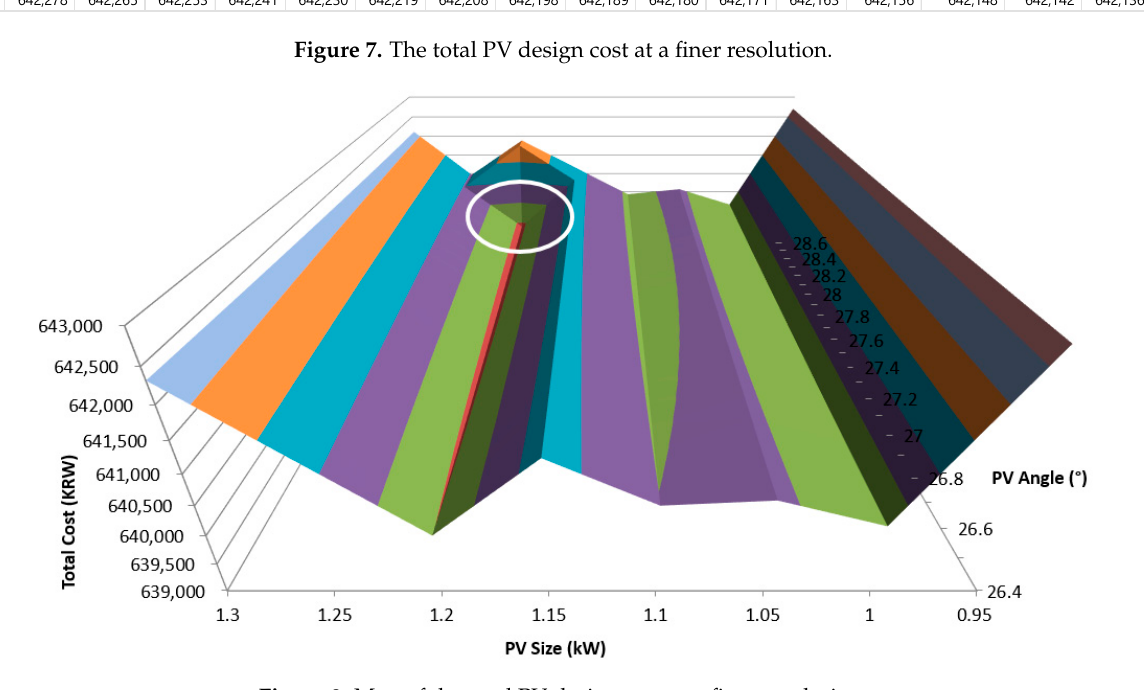
Figure 8. Map of the total PV design cost at a finer resolution.